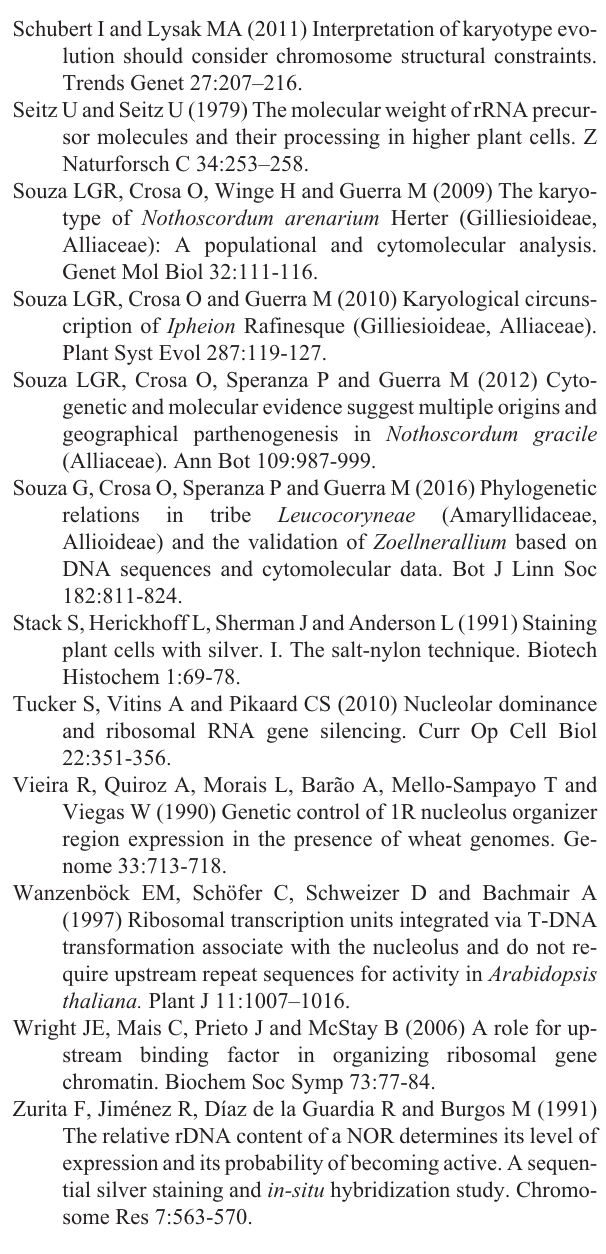
Table S1 – Number of NORs in species with rDNA sites only on acrocentric short arms Table S2 – Patterns of NORs in species with rDNA sites only in metacentric Table S3 – Patterns of NORs in species with rDNA sites in acrocentric and